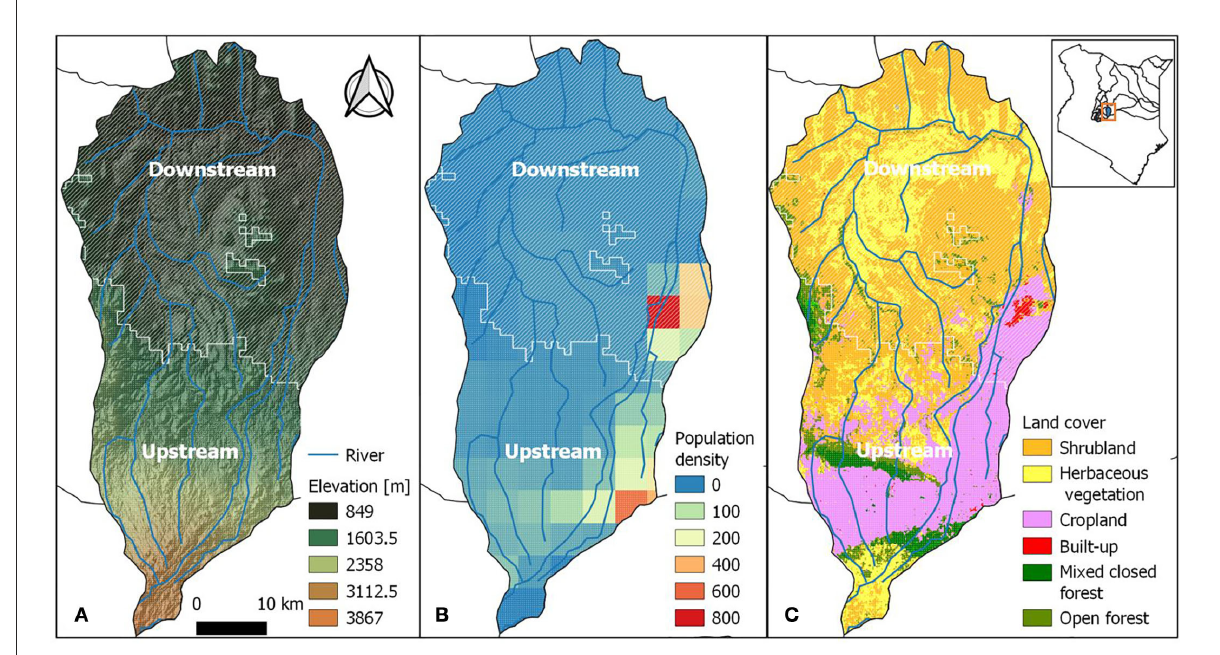
FIGURE2 Sub-catchment of Upper Ewaso N’giro basin in Kenya. Elevation (A) , population density (B) , and land cover (C)